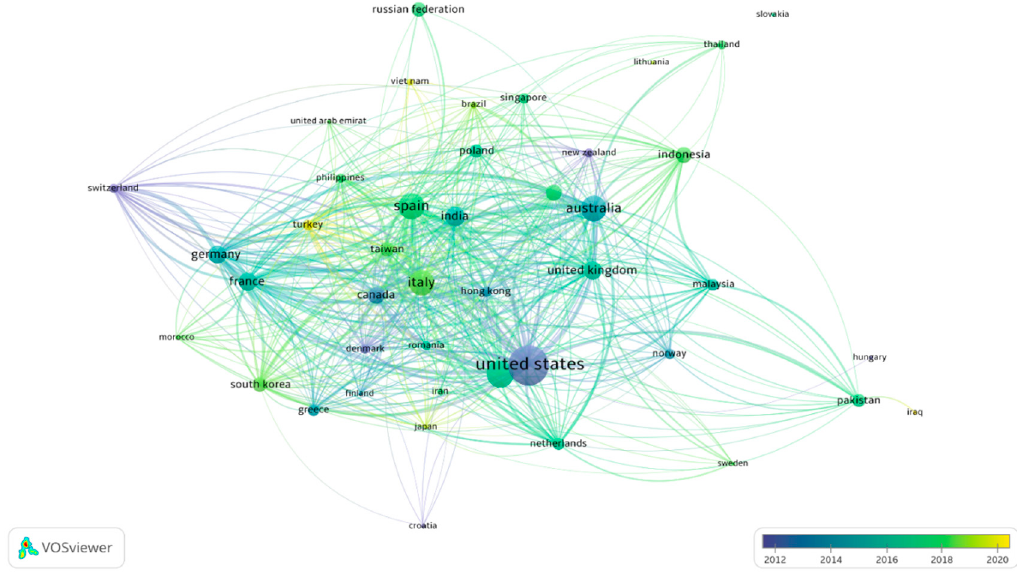
Figure 3. Bibliographic coupling of countries / territories by publication year.